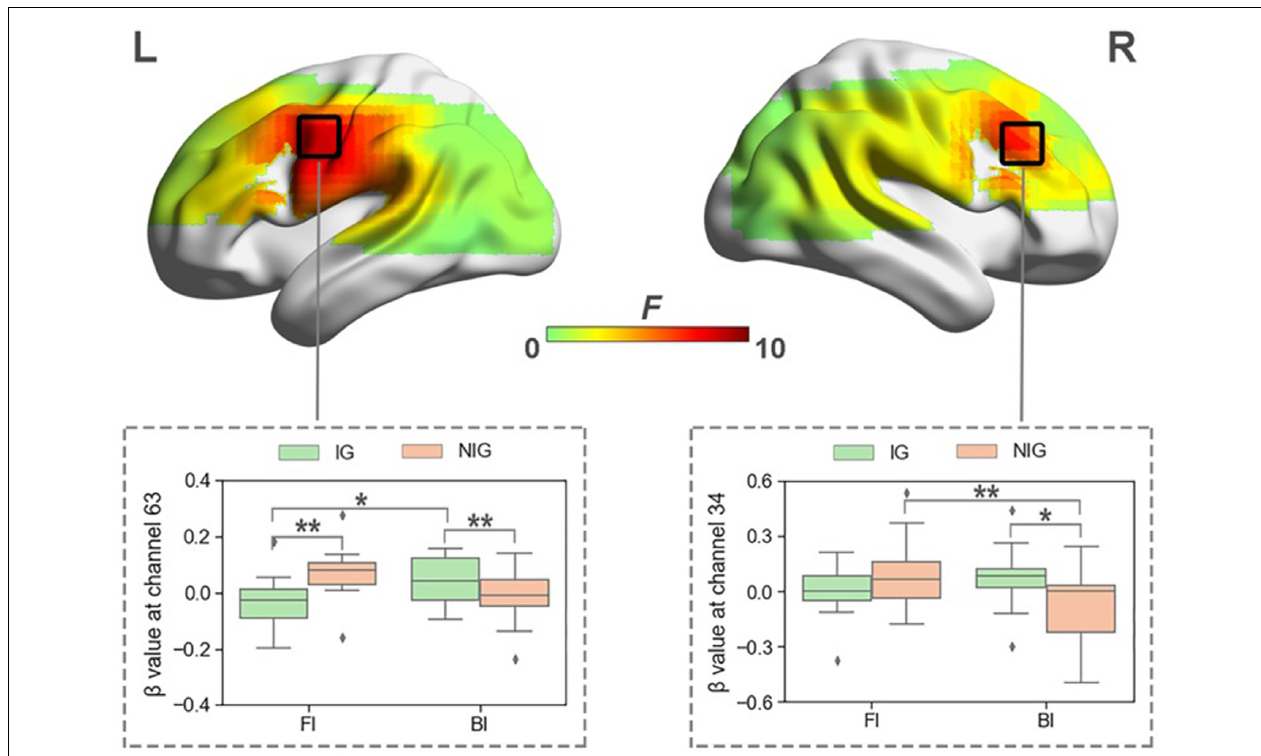
FIGURE 6 | The heat map corresponding to the activated channels impacted by the interaction between interpreting direction and interpreting expertise in HbO, when normalized for vocalization; the average β value for such interaction in the activated channels. * p < 0.05; ** p < 0.01. Error bars represent minimum/maximum values. The diamond dots mean extreme values. The shaded area indicates the 95% confidence